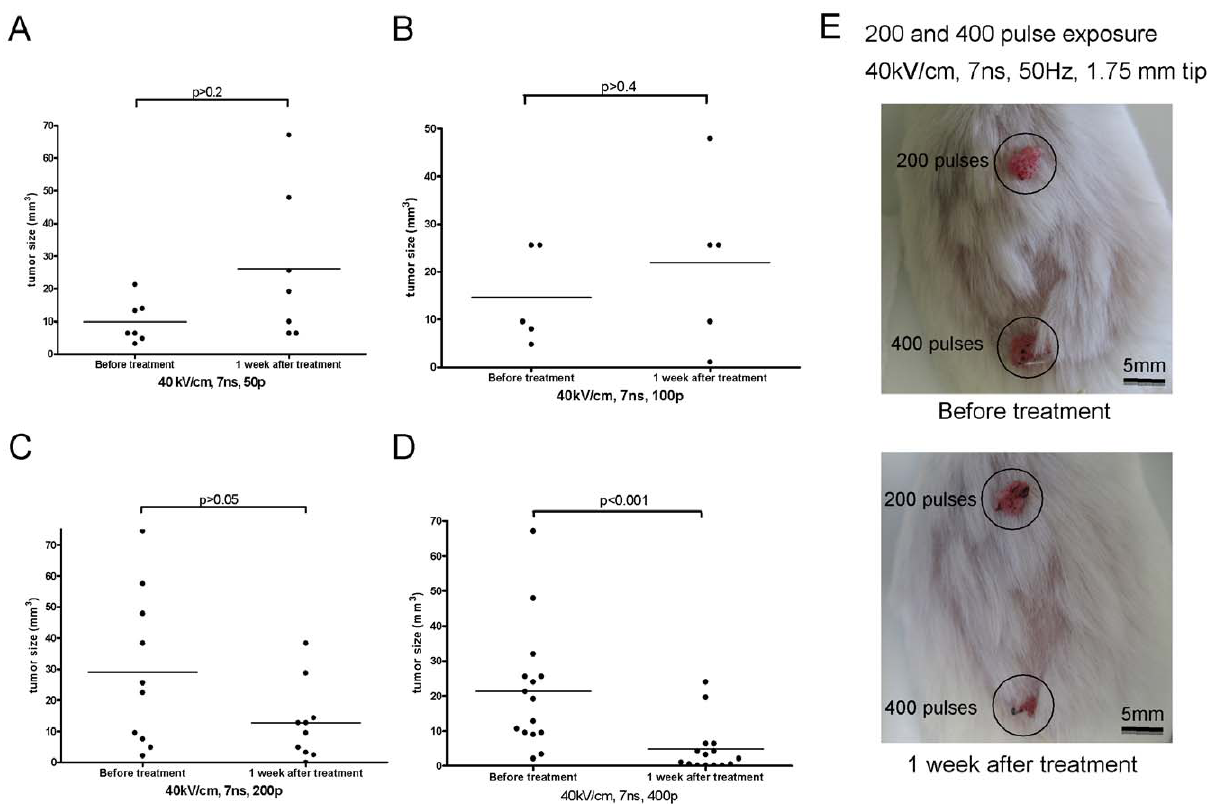
Figure 3. Treatment of induced papillomas and squamous cell carcinomas invivo with nsPEF (7ns). nsPEF exposure (7 ns) of carcinogen induced squamous cell carcinomas in vivo . Induced tumors were exposed to 50, 100, 200 or 400 pulses of 7 ns duration, at 50 Hz and 40 kV/cm peak nominal electric field (Panels A, n=7, median size=6.4 mm 3 before ureatment, 19.2 mm 3 after treatment; B, n=5, median size=9.6 mm 3 before ureatment, 25.6 mm 3 after treatment; C, n=10, median size=23.9 mm 3 before ureatment, 11.2 mm 3 after treatment; D, n=15, median size=19.2 mm 3 before ureatment, 2.1 mm 3 after treatment). Tumor sizes were measured prior to and at 1-week post exposure. The solid lines depict mean tumor size in each group. Images (Panel E ) are representative of the experiments and show pre- and one week post-exposure to either 200 or 400 pulses.